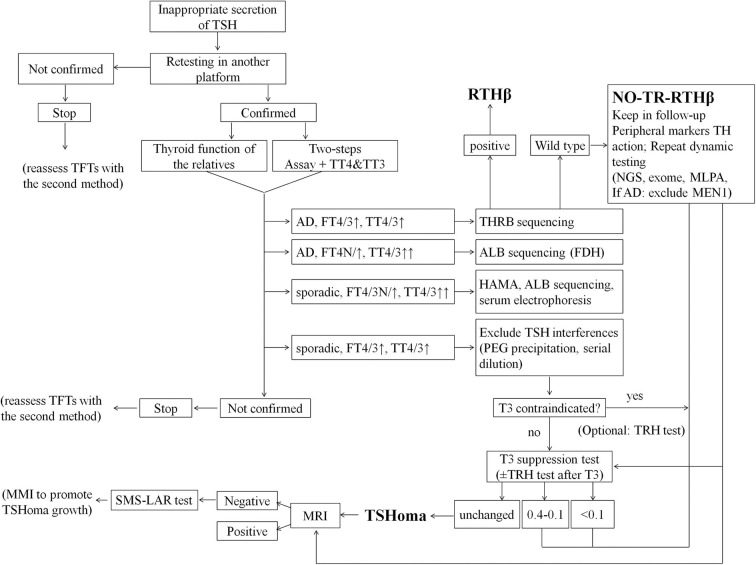
Flowchart for more effective differential diagnosis of inappropriate TSH secretion. This flow-chart represents our proposed cost-effective work up for the differential diagnosis of inappropriate TSH secretion. Final diagnoses are indicated in bold; optional tests are indicated in parentheses. AD, autosomal dominant; ALB, albumin gene; FDH, Familial dysalbuminemic hyperthyroxinemia (FDH); HAMA, Human anti-mouse antibodies; MEN1, Multiple Endocrine Neoplasia type 1; MLPA, Multiplex Ligation Probe Amplification; MMI, methimazole; NGS, next generation sequence; PEG, polyethylene glycol; SMS-LAR, long-acting-release somatostatin analog; TFTs, thyroid function tests; TH, thyroid hormones; TT4, total T4; TT3, total T3.